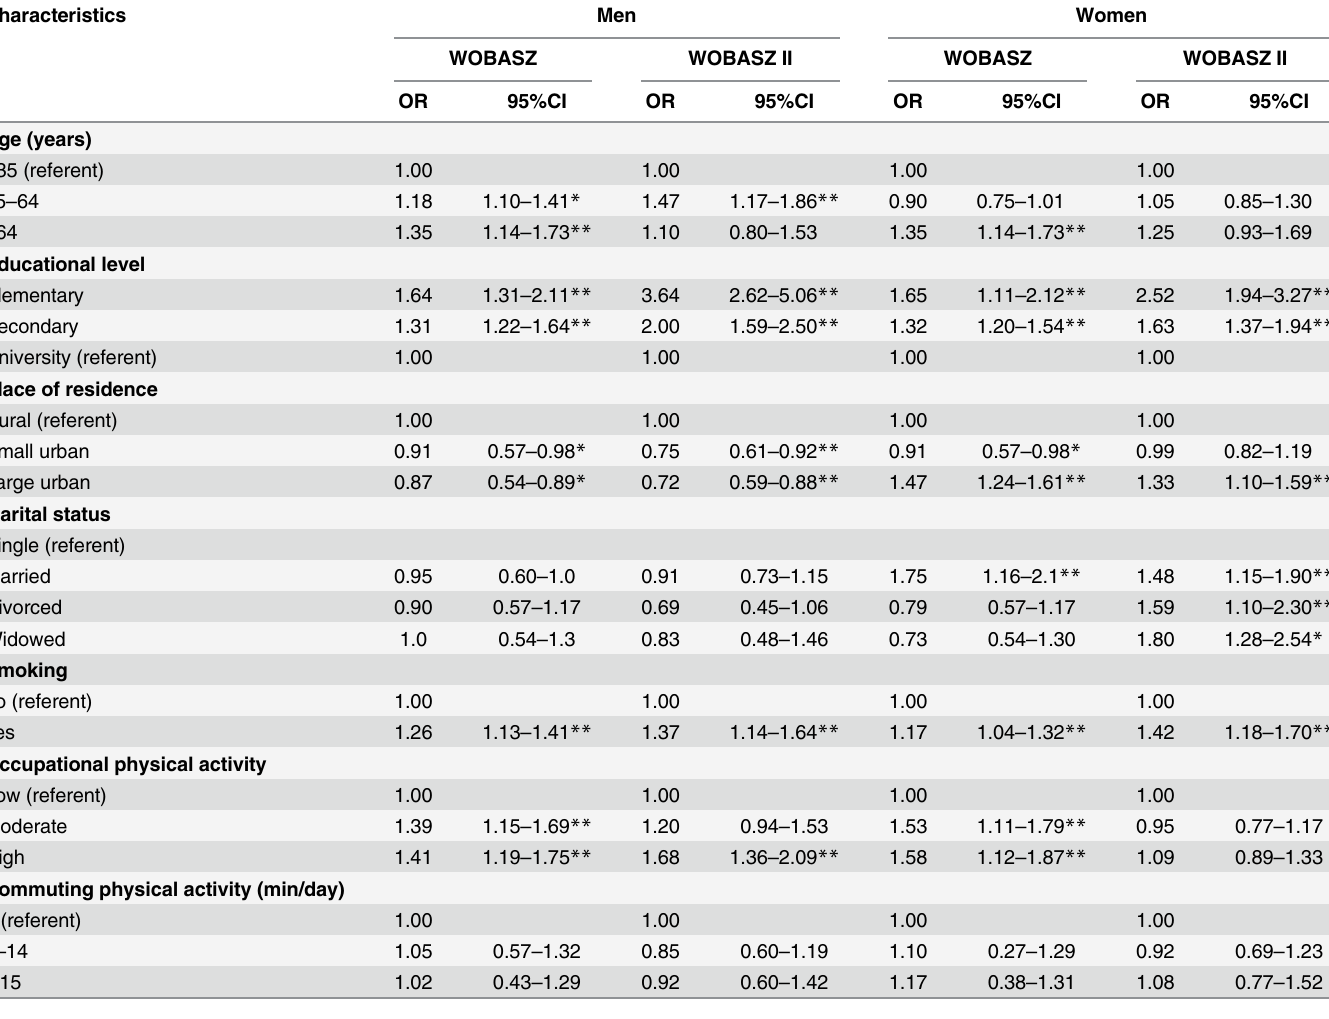
Table 2. Odds Ratios (OR) a and 95% Confidence Intervals (CI) for inactivity during leisure-time to sociodemographic and PA characteristics among participants of the WOBASZ (2003 – 2005) and WOBASZ II (2013 – 2014) surveys.